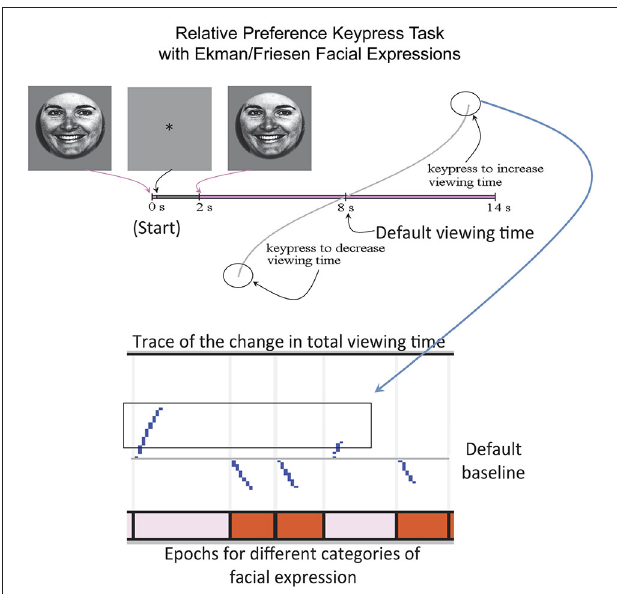
FIGURE 1 | Schema for Experimental Paradigm Used with fMRI . At top, the categories of facial expressions used are shown along with baselines (scrambled faces and fixation). A schema of how these stimuli